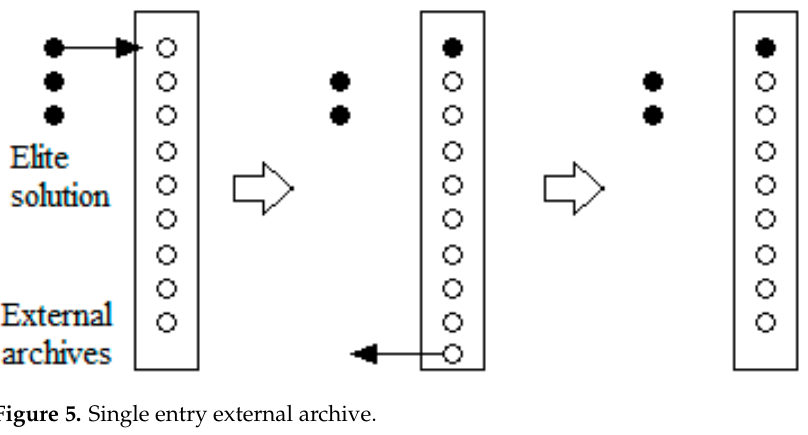
Figure 5. Single entry external archive.